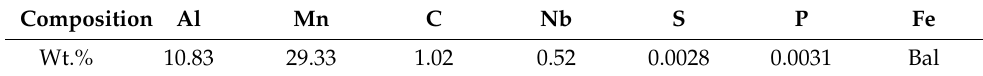
Figure 1. Test setup and the details of tensile specimens of the dog bone geometry. Table 1. Chemical compositions of the designed steels.